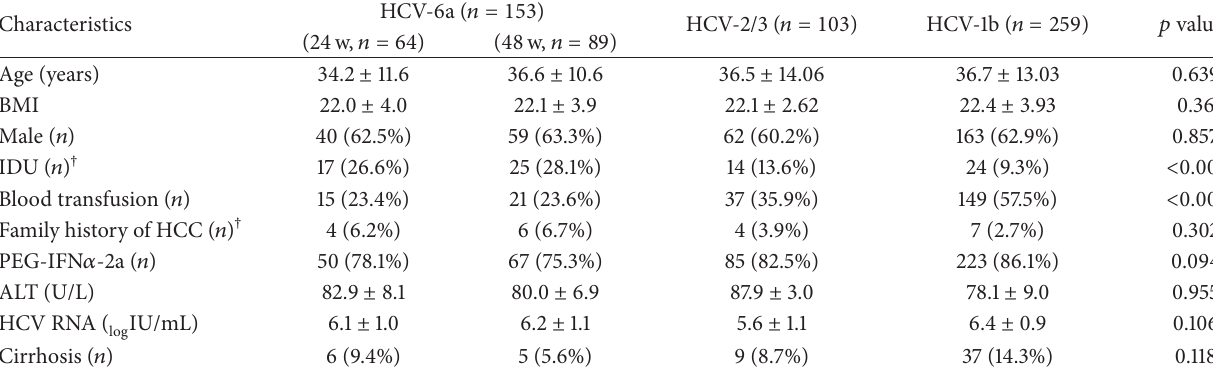
Table 1: The baseline characteristics of patients with different HCV genotype infection. Characteristics